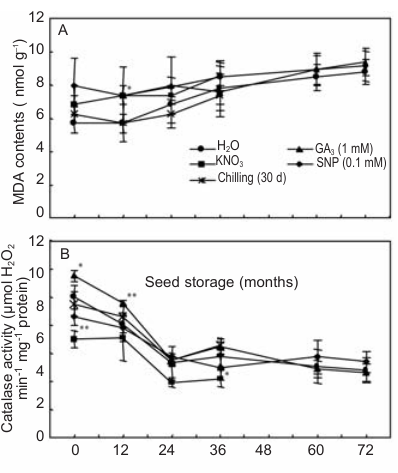
Figure 5. Effect of seed pre-treatments on lipid peroxidation status (A) and catalase activity (B) of differentially stored seeds of H. niger. Data are average of 3 measure- ments each ± s.d. Different from respective controls based on ‘t’ statistic: * (P ≤ 0.05); ** (P ≤ 0.01).